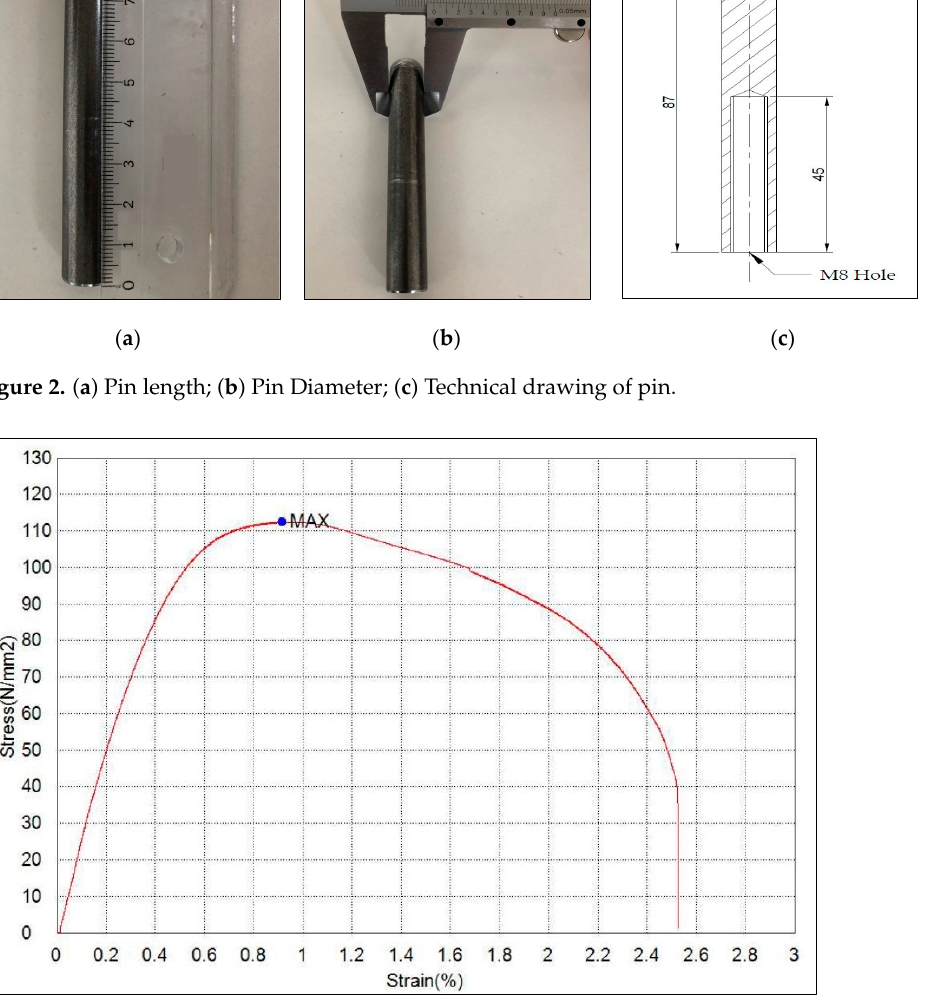
Figure 4. Aspect of tensile test specimen. The final shape of the sheet parts was obtained from a 150 × 150 mm sheet blank. Form1 was a V-type part, form2 was a wavy shape, and form3 was a 3D free-form surface. The technical drawings of the three forms are shown in Figure 5. ( a ) ( b )